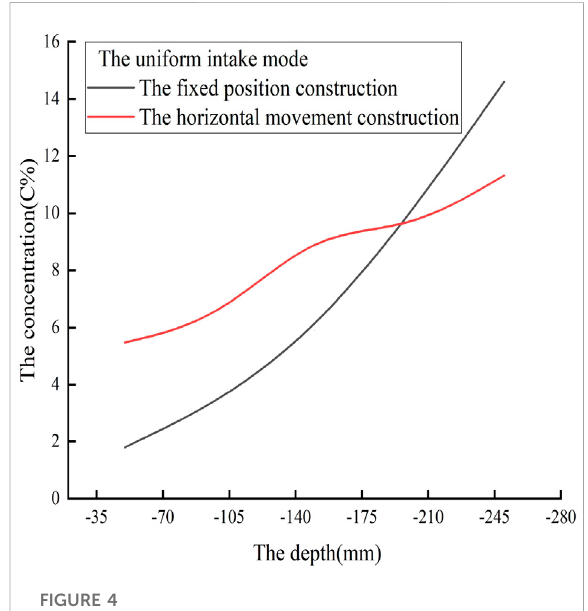
FIGURE 4 Variation of particle concentration with sand